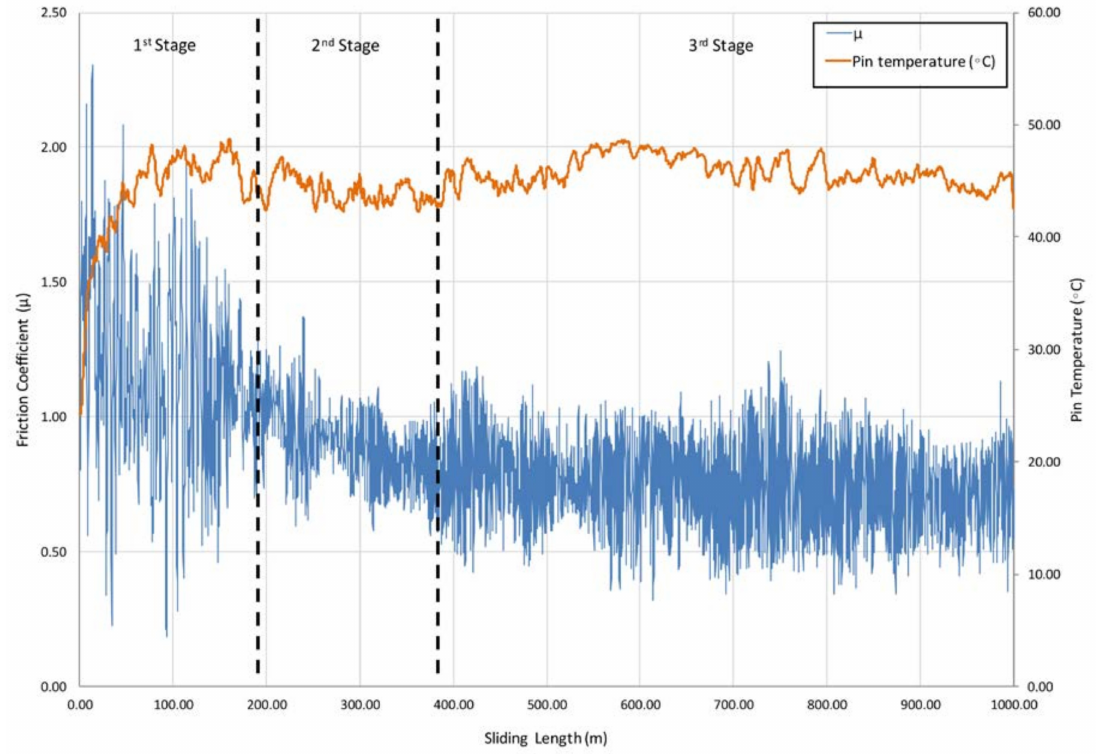
Figure 3. Friction coefficient and pin temperature as a function of sliding length for 1000